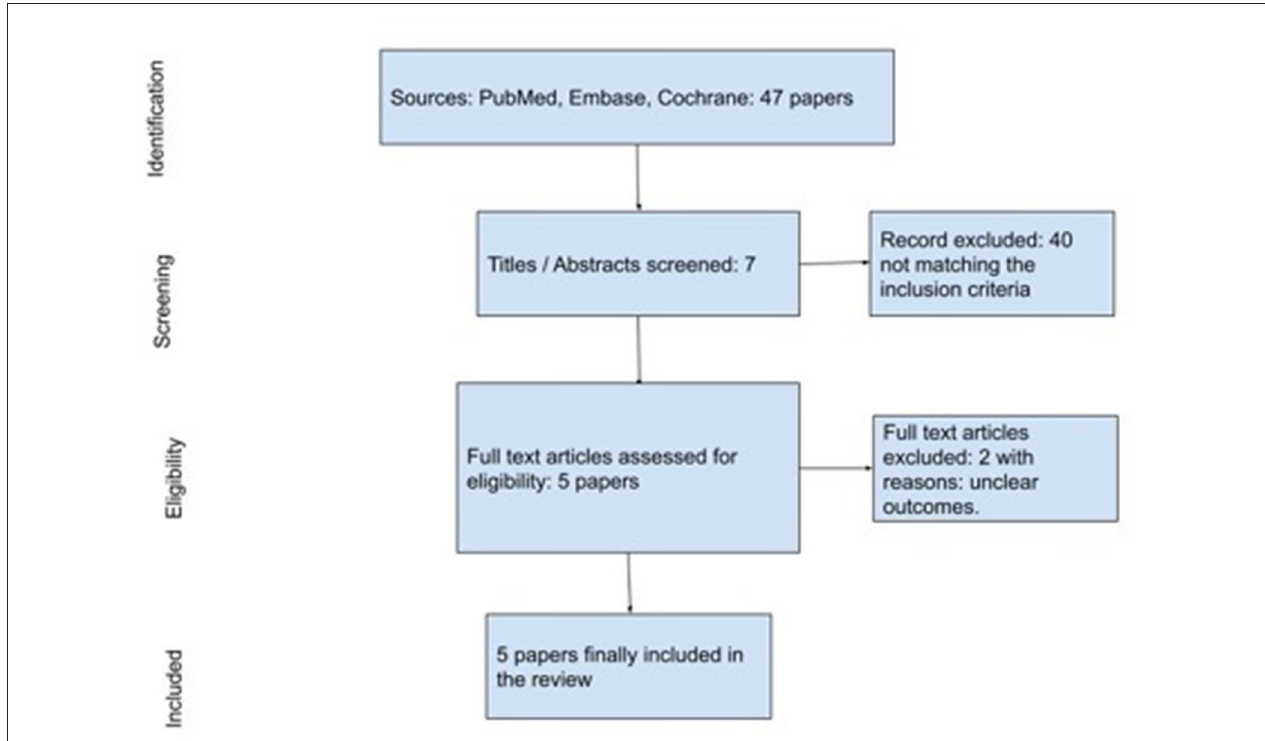
FIGURE 1 | Search